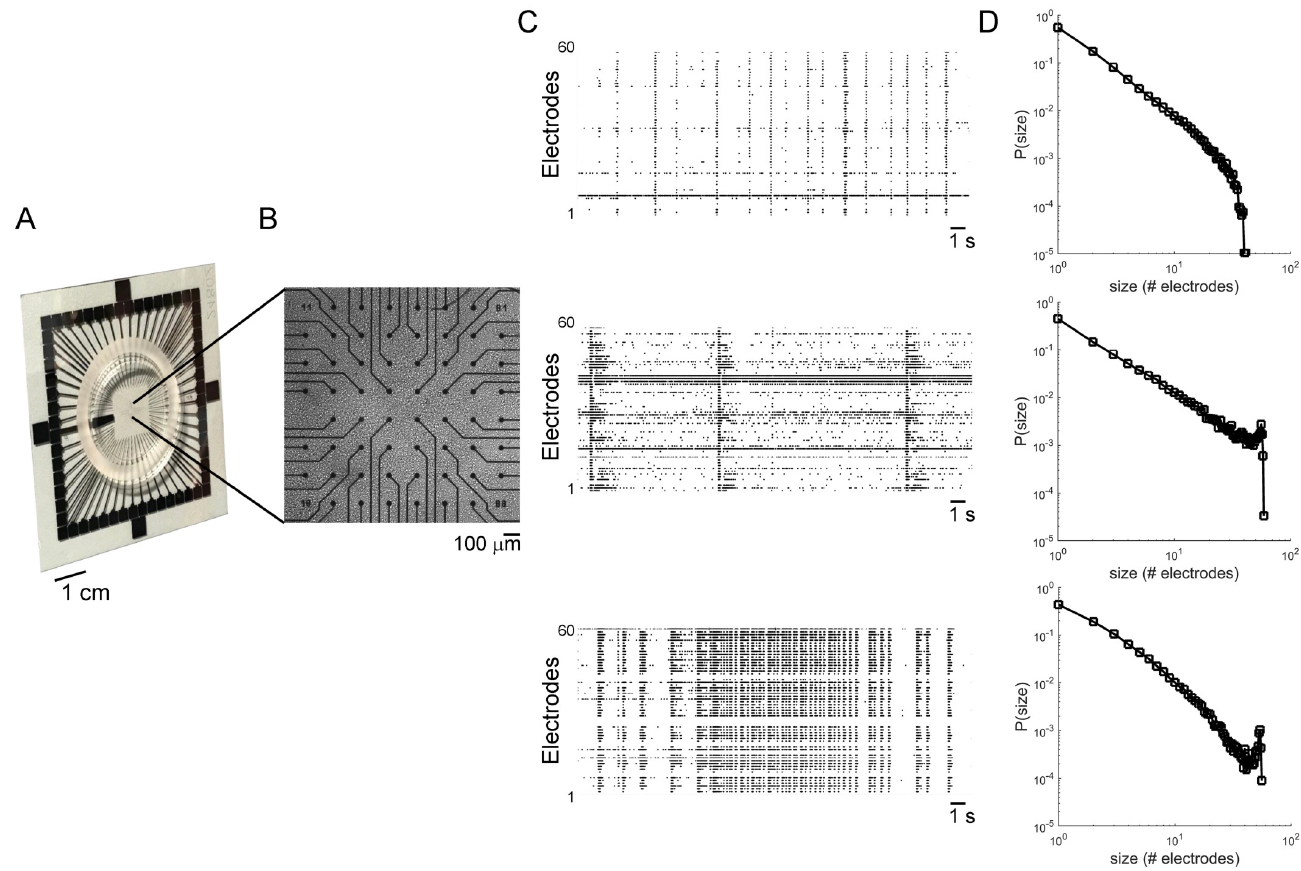
Figure 1. ( A ) Micro-Electrode Array (MEA) made up of 60 electrodes. ( B ) Example of a cortical network coupled to a MEA. ( C ) Three examples of electrophysiological activity exhibited by three different cortical networks and ( D ) corresponding distributions of avalanches